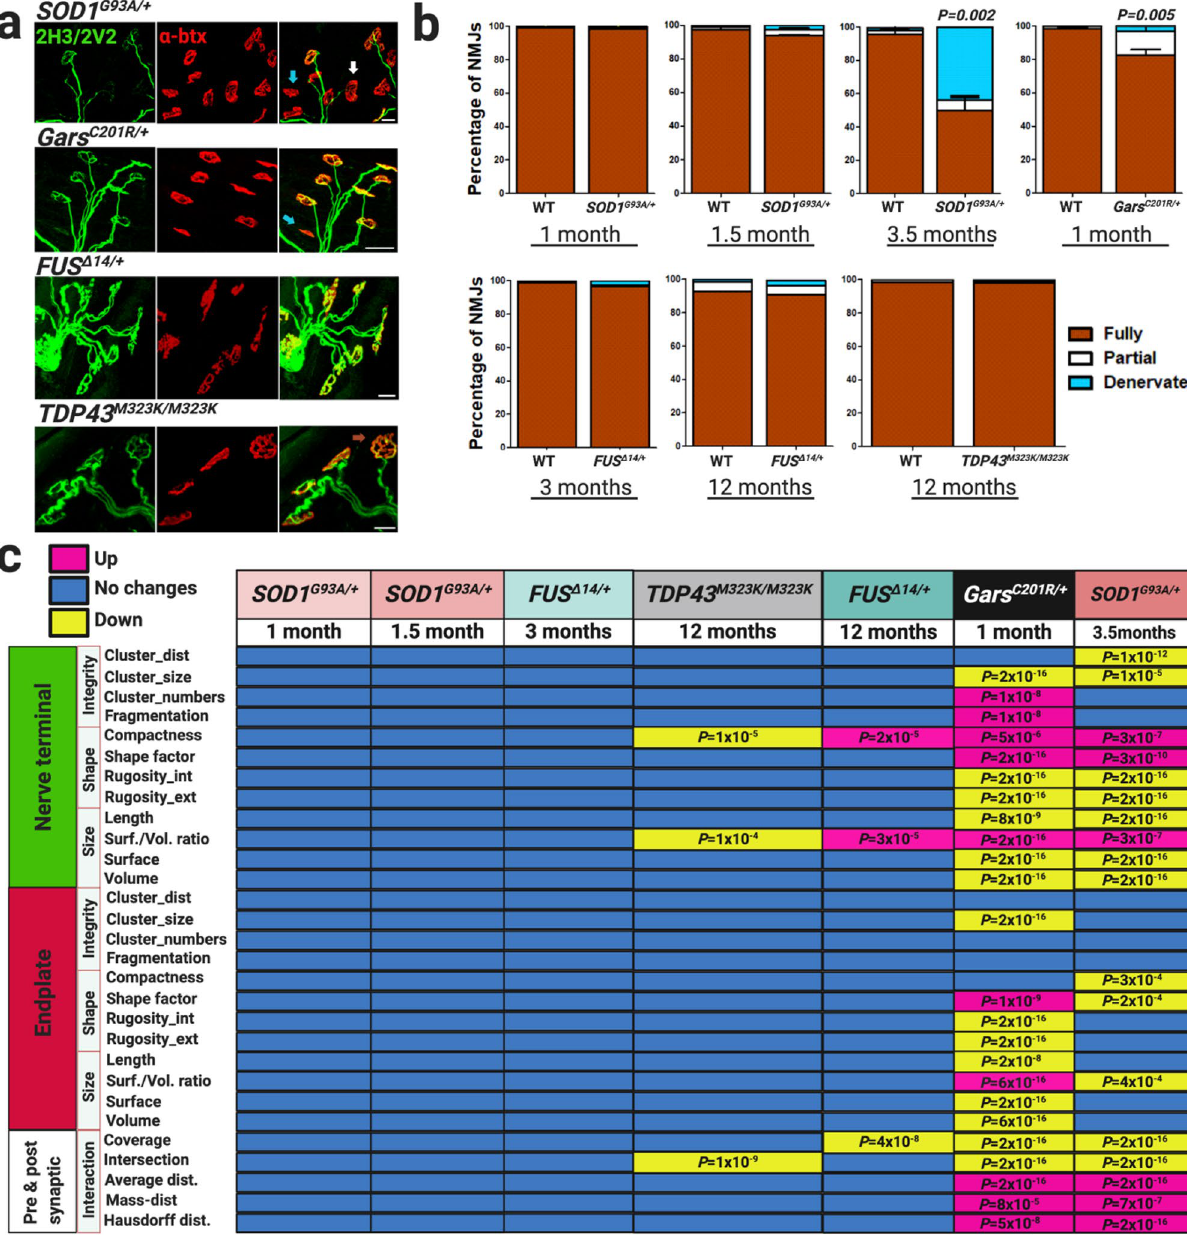
Figure 3. Automatic analysis detects changes before manual assessment of NMJs in ALS and CMT2D mouse models. ( a ) Confocal images of NMJs visualized using nerve terminal markers (2H3 + SV2, green) and motor endplate staining (α-btx, red). Images correspond to SOD1 G93A/ + (3.5 months), Gars C201R/ + (1 month), FUS Δ14/ + (12 months) and TDP43 M323K/M323K (12 months). Arrows point to examples of full (dark orange), partial (white) and denervated NMJs (sky-blue). ( b ) NMJ innervation status evaluated by eye in whole-mount lumbrical muscles in ALS and CMT2D mouse models. 3.5-month old SOD1 G93A/ + and 1-month old Gars C201R/ + mice had a significant reduction in the percentage of fully innervated NMJs (* P value ≤ 0.05, Wilcoxon signed- rank test, two-tailed). ( c ) Module displaying NMJ morphological parameters measured in ALS and CMT2D strains using NMJ-Analyser. Each timepoint analysed was compared to their respective sex- and aged-matched WT littermates: * P value ≤ 5 × 10 −4 was considered significant. Percentage of innervation ± S.E.M. are plotted. Number of mice, WT and mutant: SOD1 G93A/ + , 1 month (5 + 5), 1.5 month (5 + 5), 3.5 months (4 + 9); Gars C201R/ + (5 + 5); FUS Δ14/ + , 3 months (4 + 4), 12 months (4 + 4); TDP43 M323K/M323K , 12 months (5 + 5). Scale bars = 20